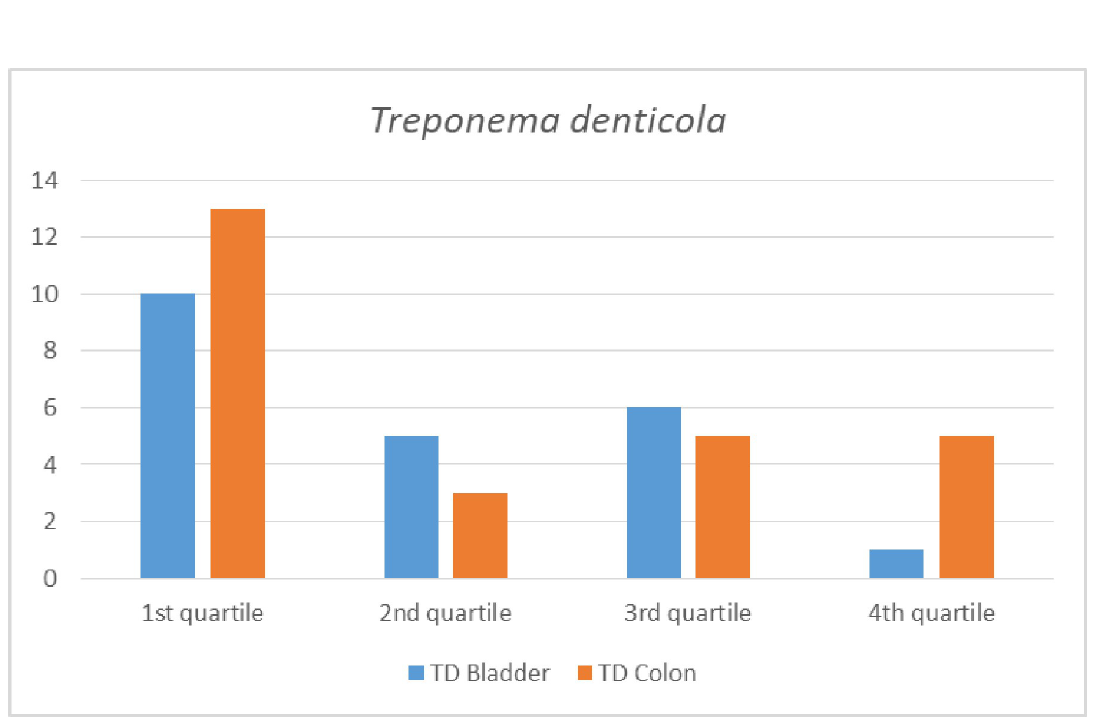
Fig 2. Number of incident cancer cases of bladder and colon by quartile antibody levels of Treponema denticola (TD) . Quartile (Q) values are Q1 1–28, Q2 29–44, Q3 45–73, Q4 74–1240.